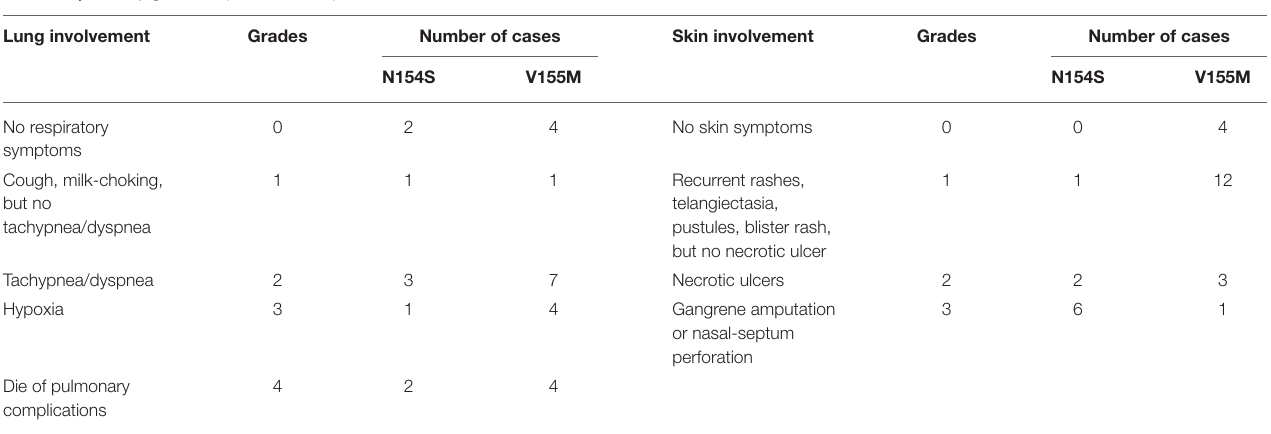
TABLE 4 | Severity grades of p.N154S and p.V155M. Lung